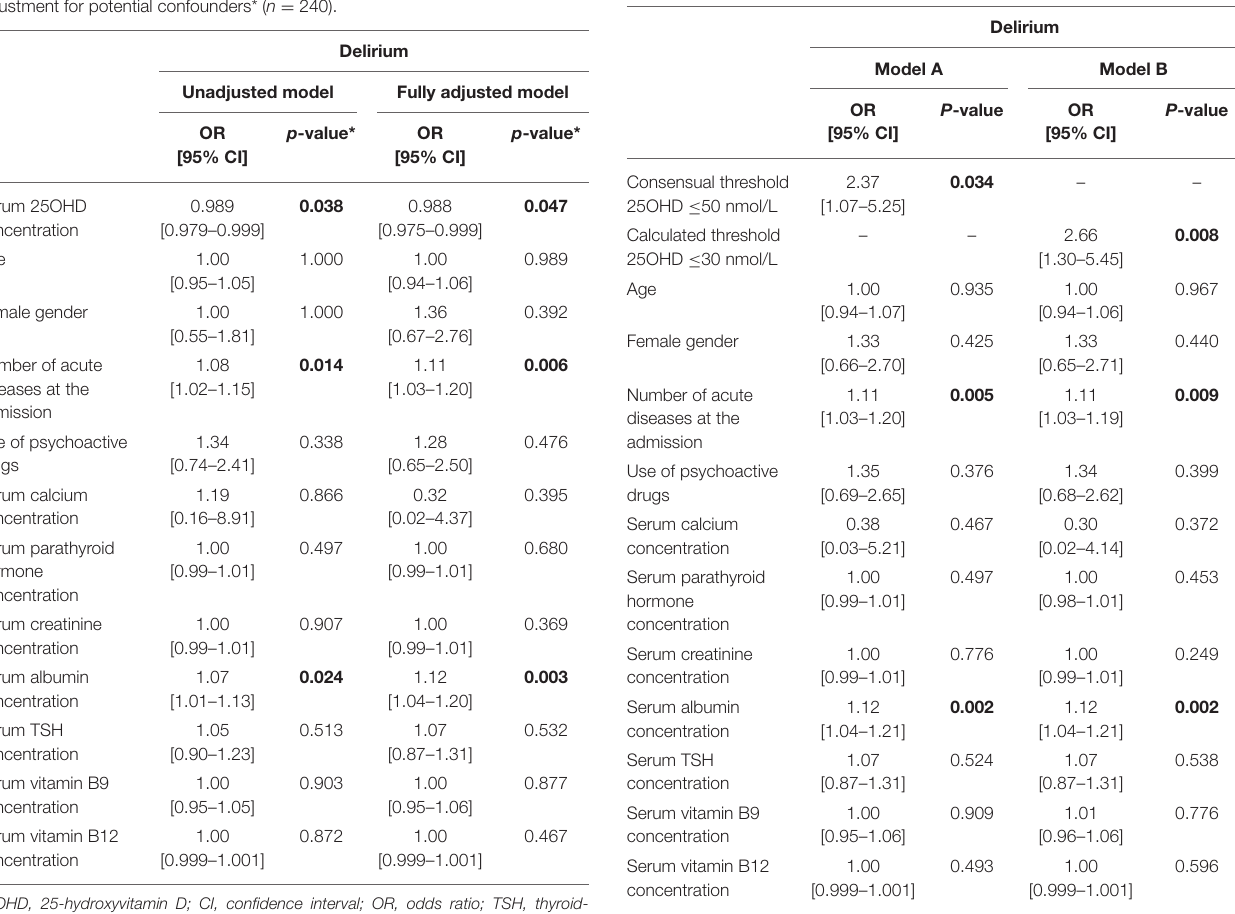
TABLE 3 | Multiple logistic regression models* assessing the cross-sectional association between delirium and hypovitaminosis D defined using (A)